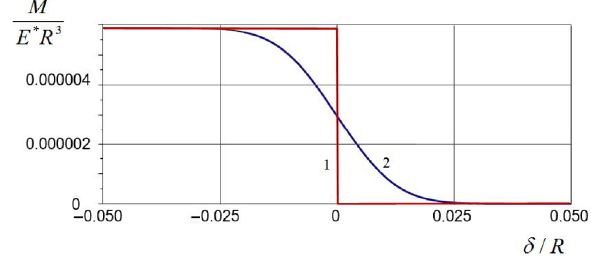
Fig. 8 Moment of rolling resistance vs dimensionless distance between a cylinder and elastic half-space.